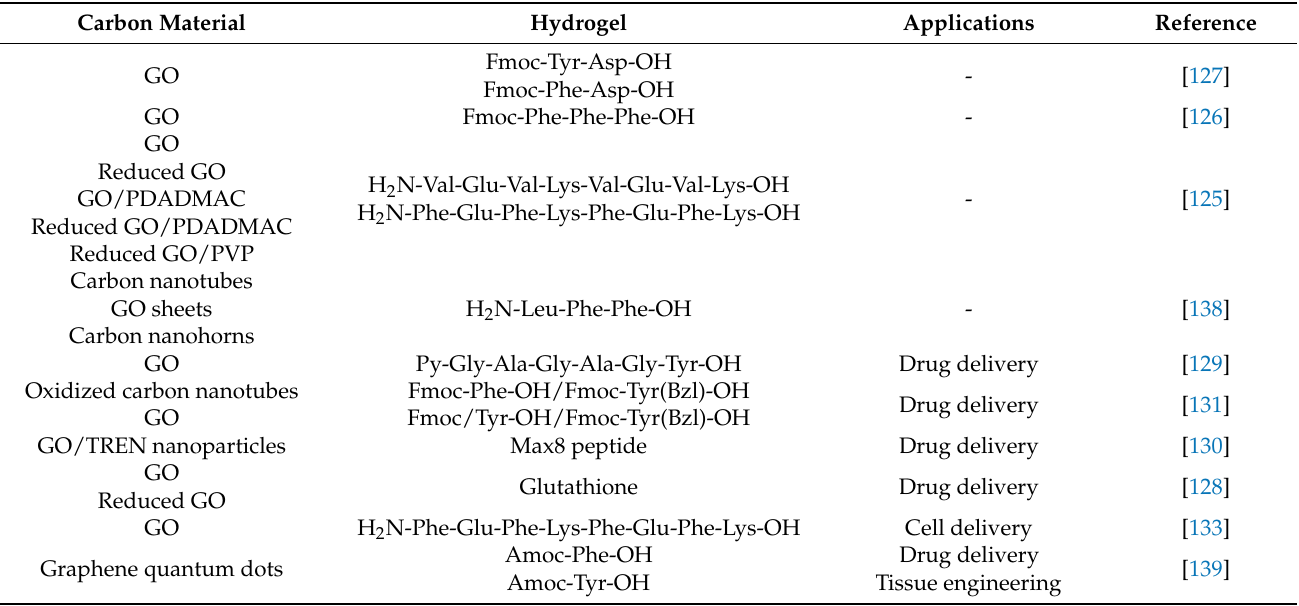
Table 4. Summary of advancements with peptide-based graphene–hydrogel